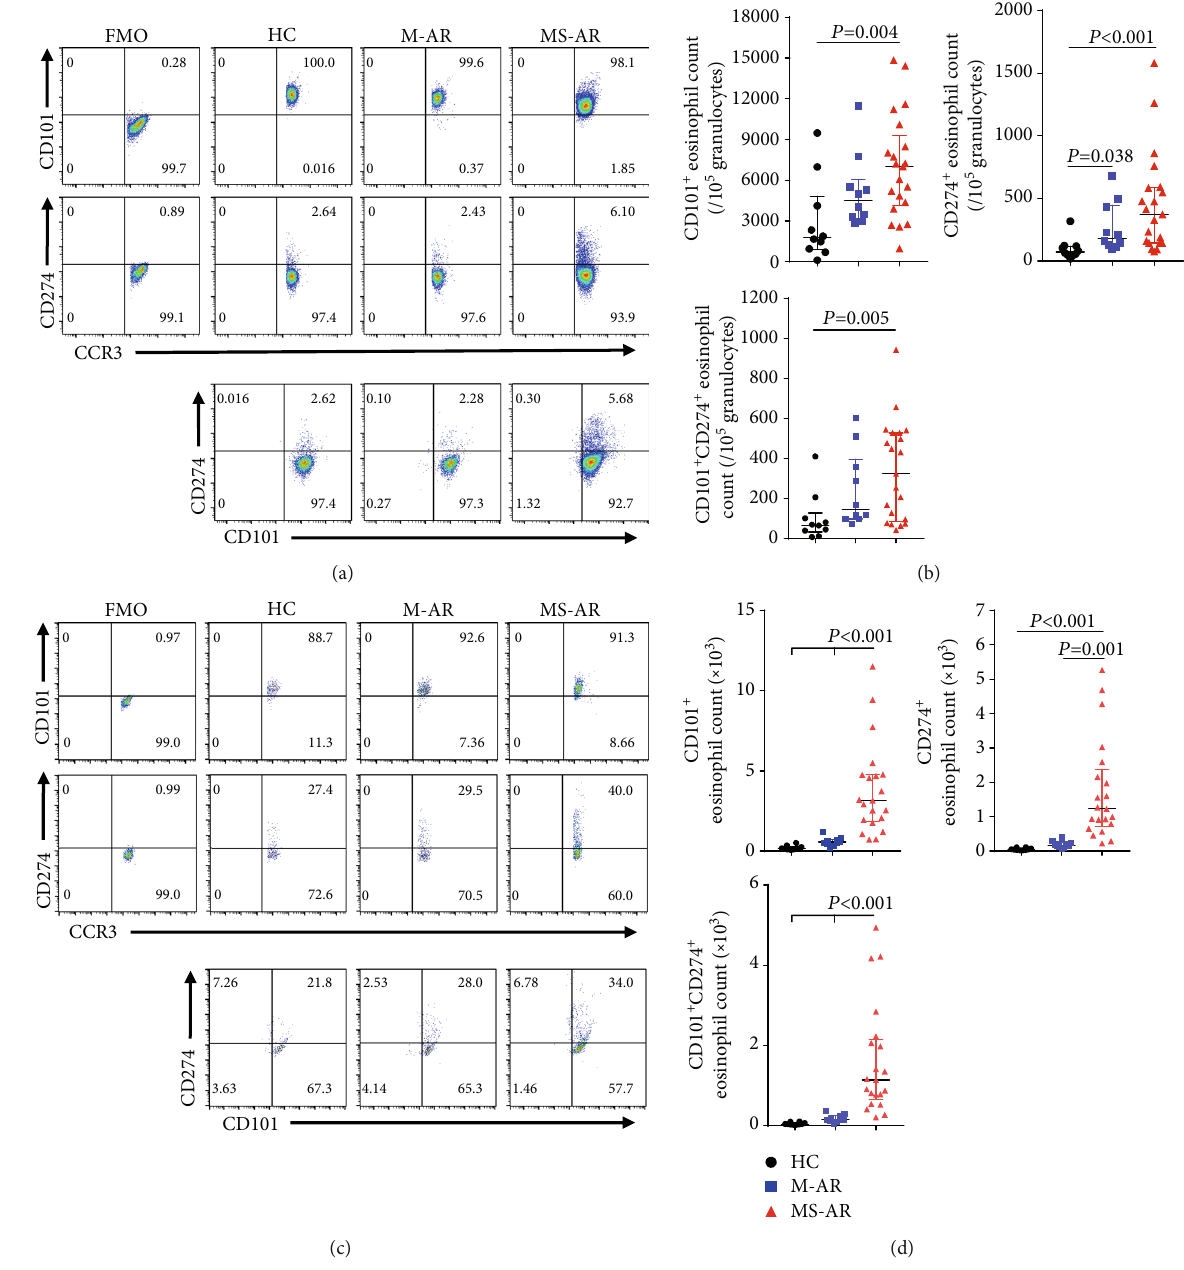
Figure 3: Pathogenic eosinophils are elevated in patients with moderate-severe allergic rhinitis. (a, c) Representative fl ow plots for identifying CD101 + and CD274 + eosinophils in the peripheral blood (a) and nose (c) of healthy controls, mild allergic rhinitis, and moderate-severe allergic rhinitis. All samples were fi rst gated on live eosinophils. (b, d) Absolute numbers of CD101 + , CD274 + , and CD101 + CD274 + eosinophils in the peripheral blood (b) and nose (d). HC: healthy controls; M-AR: mild allergic rhinitis; MS-AR: moderate-severe allergic rhinitis; FMO: fl uorescence minus one